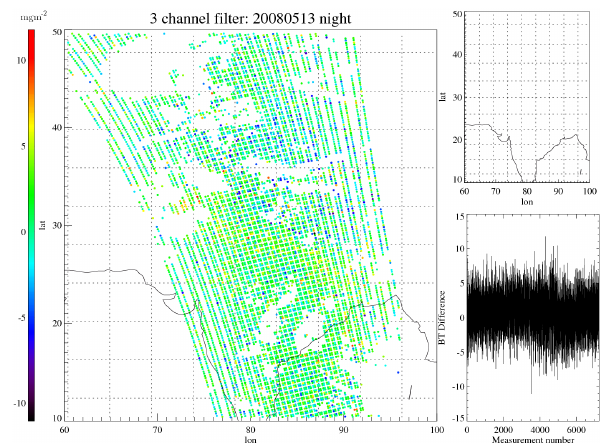
Fig. 13. Ammonia as seen by IASI for the nighttime overpass on 13 May 2008 using the exising three channel filter with estimated total column amounts given in mgm − 2 . A map of positive detec- tions in the 99% confidence interval is shown in the top-right panel of each figure. The distribution of detected ammonia for each mea- surement is shown in the bottom-right